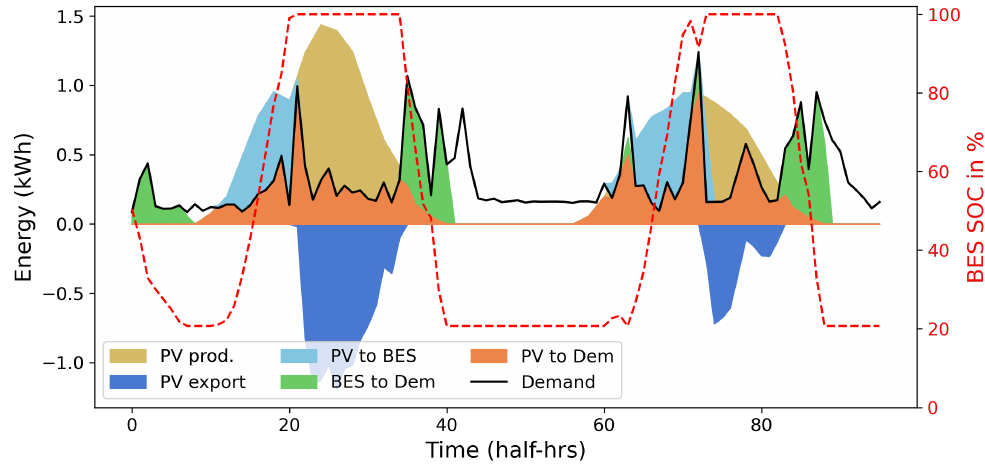
Figure 4. Operation of the PV and BES for the randomly selected consumer for two example